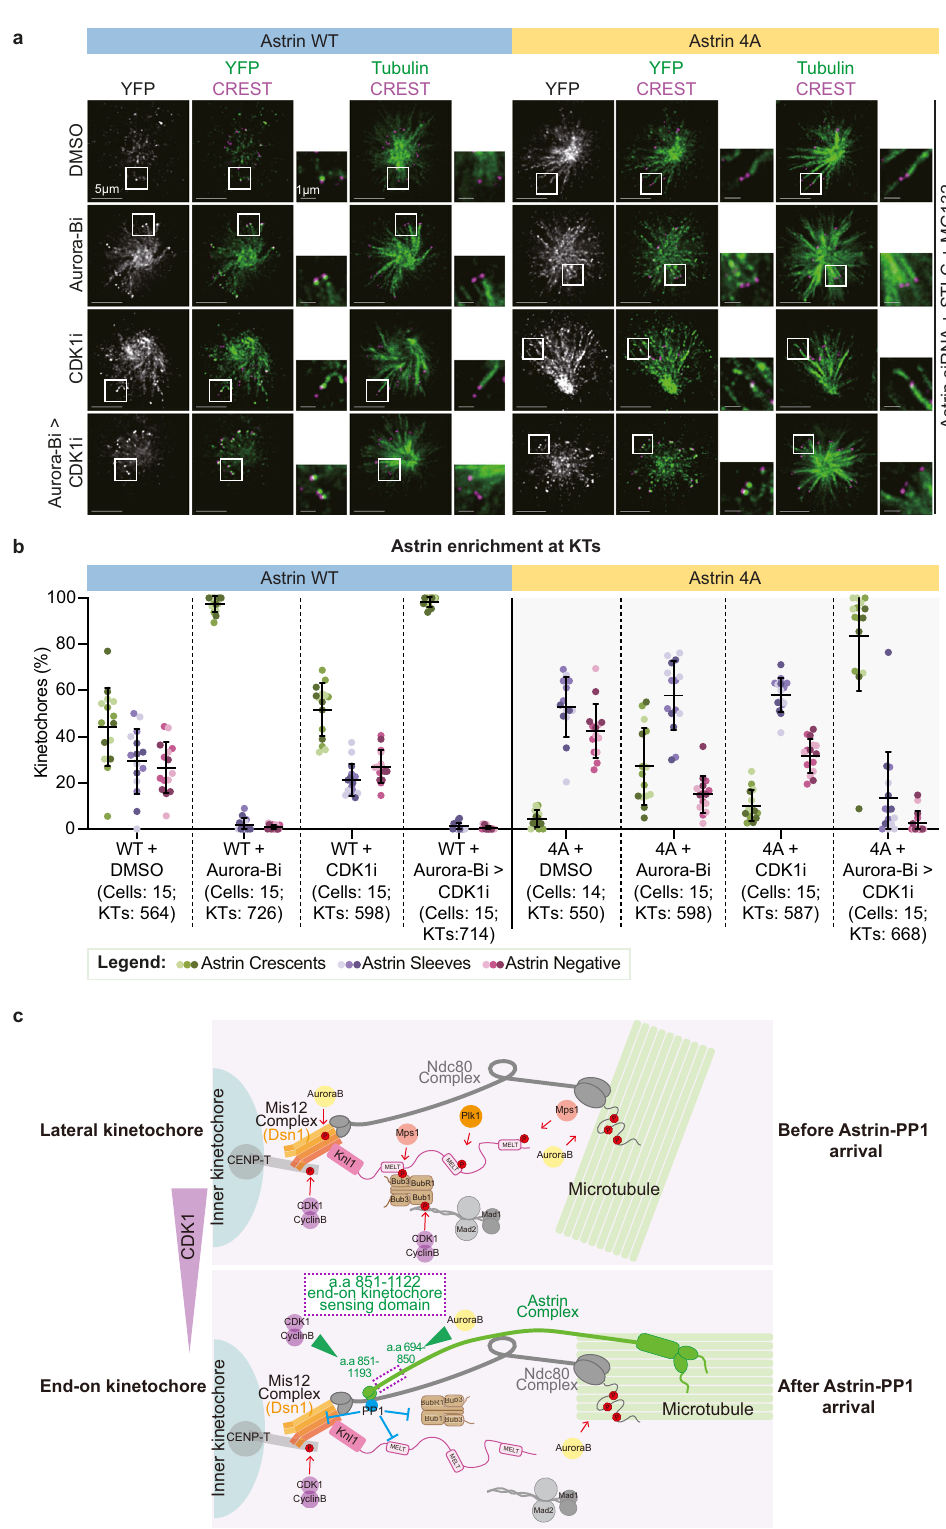
Methods Cell culture and drug treatments . HeLa cells (ATCC) cultured in Dulbecco ’ s Modi fi ed Eagle ’ s Media and RPE1 cells (ATCC) cultured in Ham ’